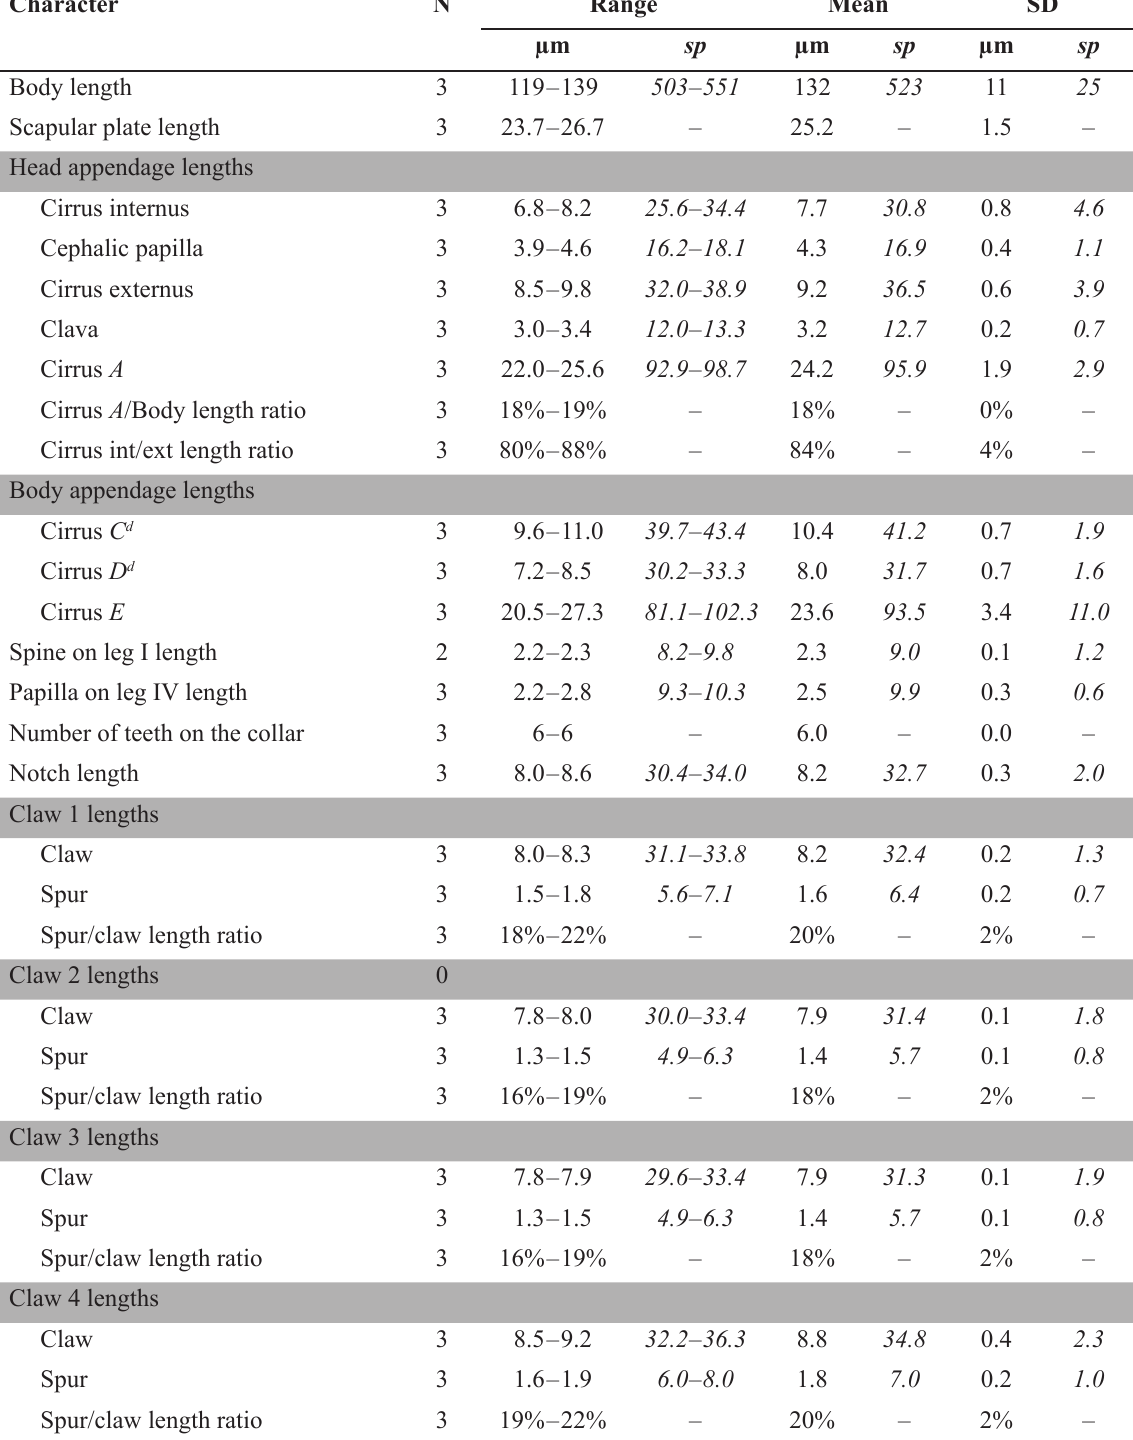
Table 4. Measurements (in µm) and sp values of selected morphological structures of larvae from the neotype population of Echiniscus q. quadrispinosus Richters, 1902 mounted in Hoyer’s medium. Abbreviations: N = number of specimens/structures measured; RANGE = refers to the smallest and the largest structure among all measured specimens; SD = standard